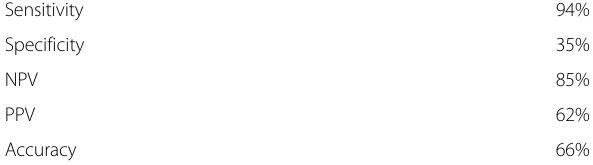
Table 1 PET/CT sensitivity, specificity, positive predictive value, negative predictive value, and accuracy for all carcinomas and adenomas with high-grade dysplasia per lesion